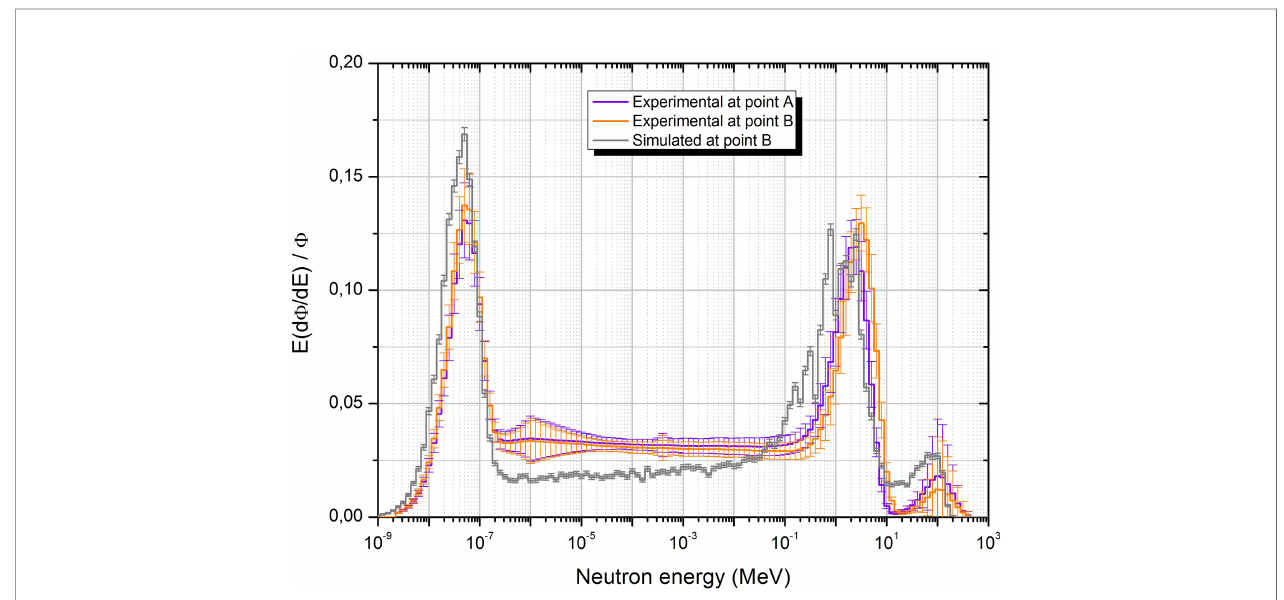
FIGURE 3 | Neutron unit spectra obtained from unfolding with FRUIT at points A and B together with the simulation spectrum at point